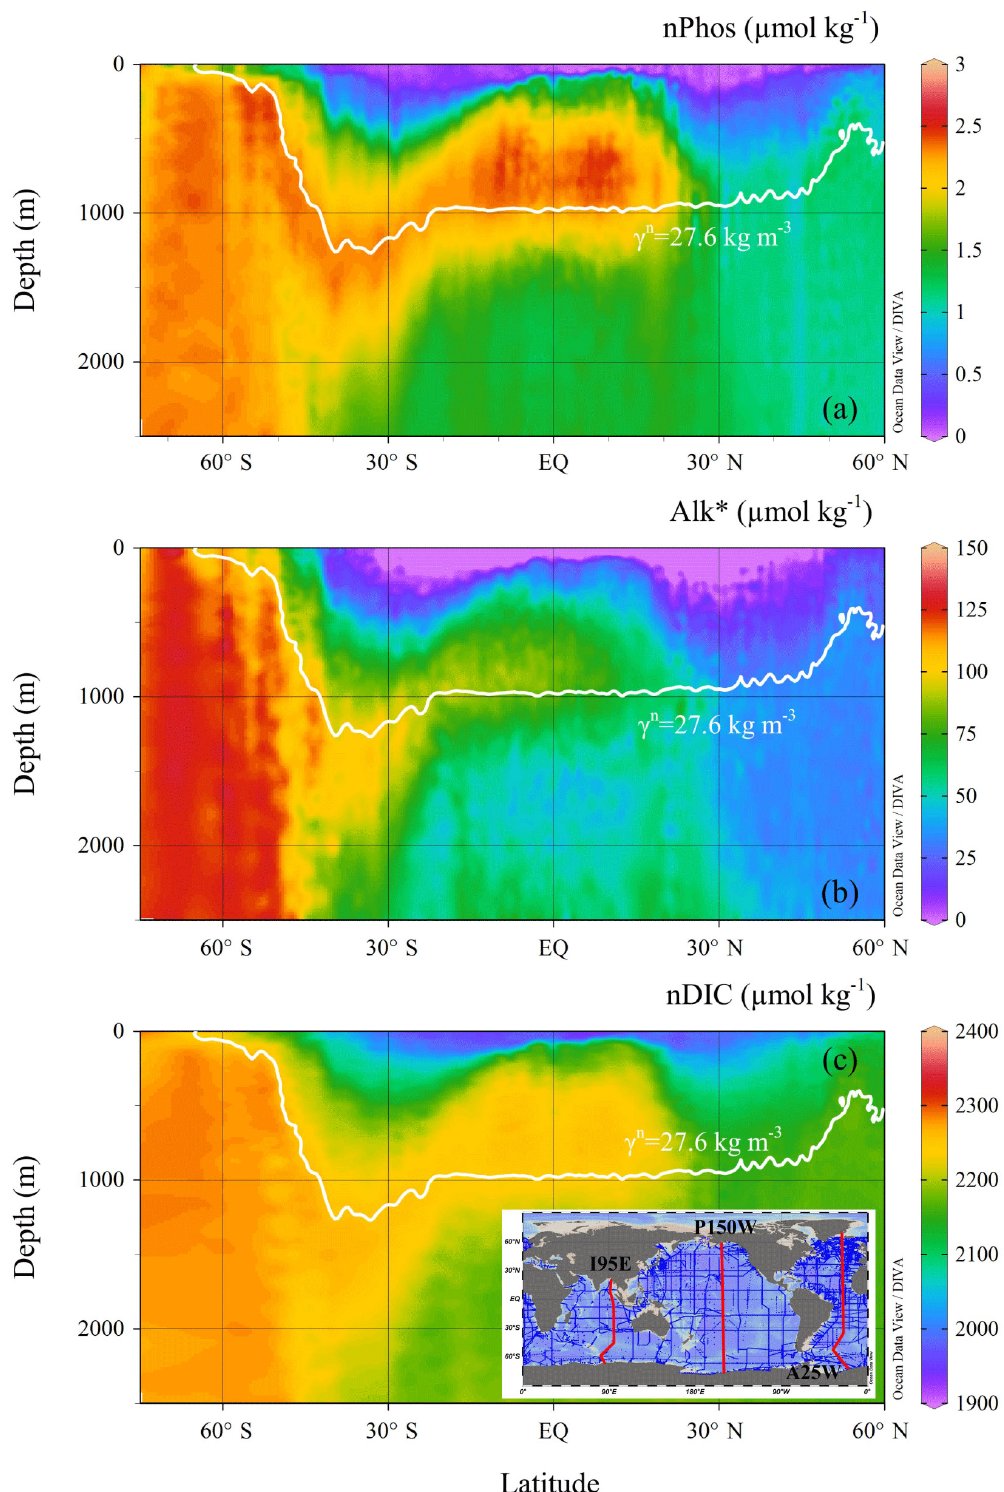
Figure 5. Vertical distributions of (a) nPhos, (b) Alk ∗ , and (c) nDIC along the Atlantic Ocean section. The Indian and Pacific sections are not shown. The selected Atlantic section (A25W) is shown as the red line on the right-hand side of the inset. The neutral density isopycnal along which upwelling occurs is indicated by the white contour, which is characterized by neutral density of 27.6kgm − 3 in the Atlantic sector of the Southern